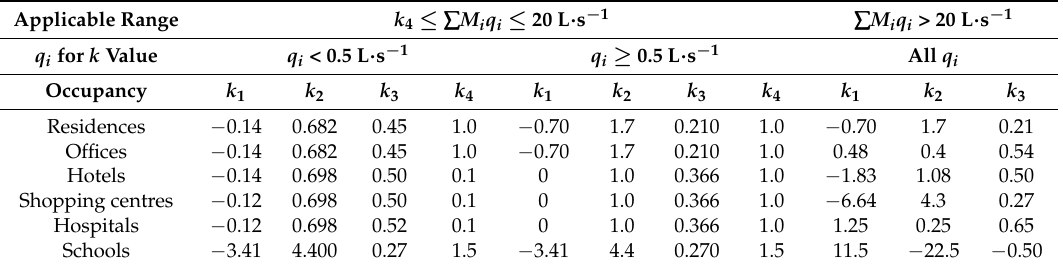
Table 1. Constants for relating the sum of unitary flow rates to the design flow rate at pipes (Deutsches Institut für Normung DIN